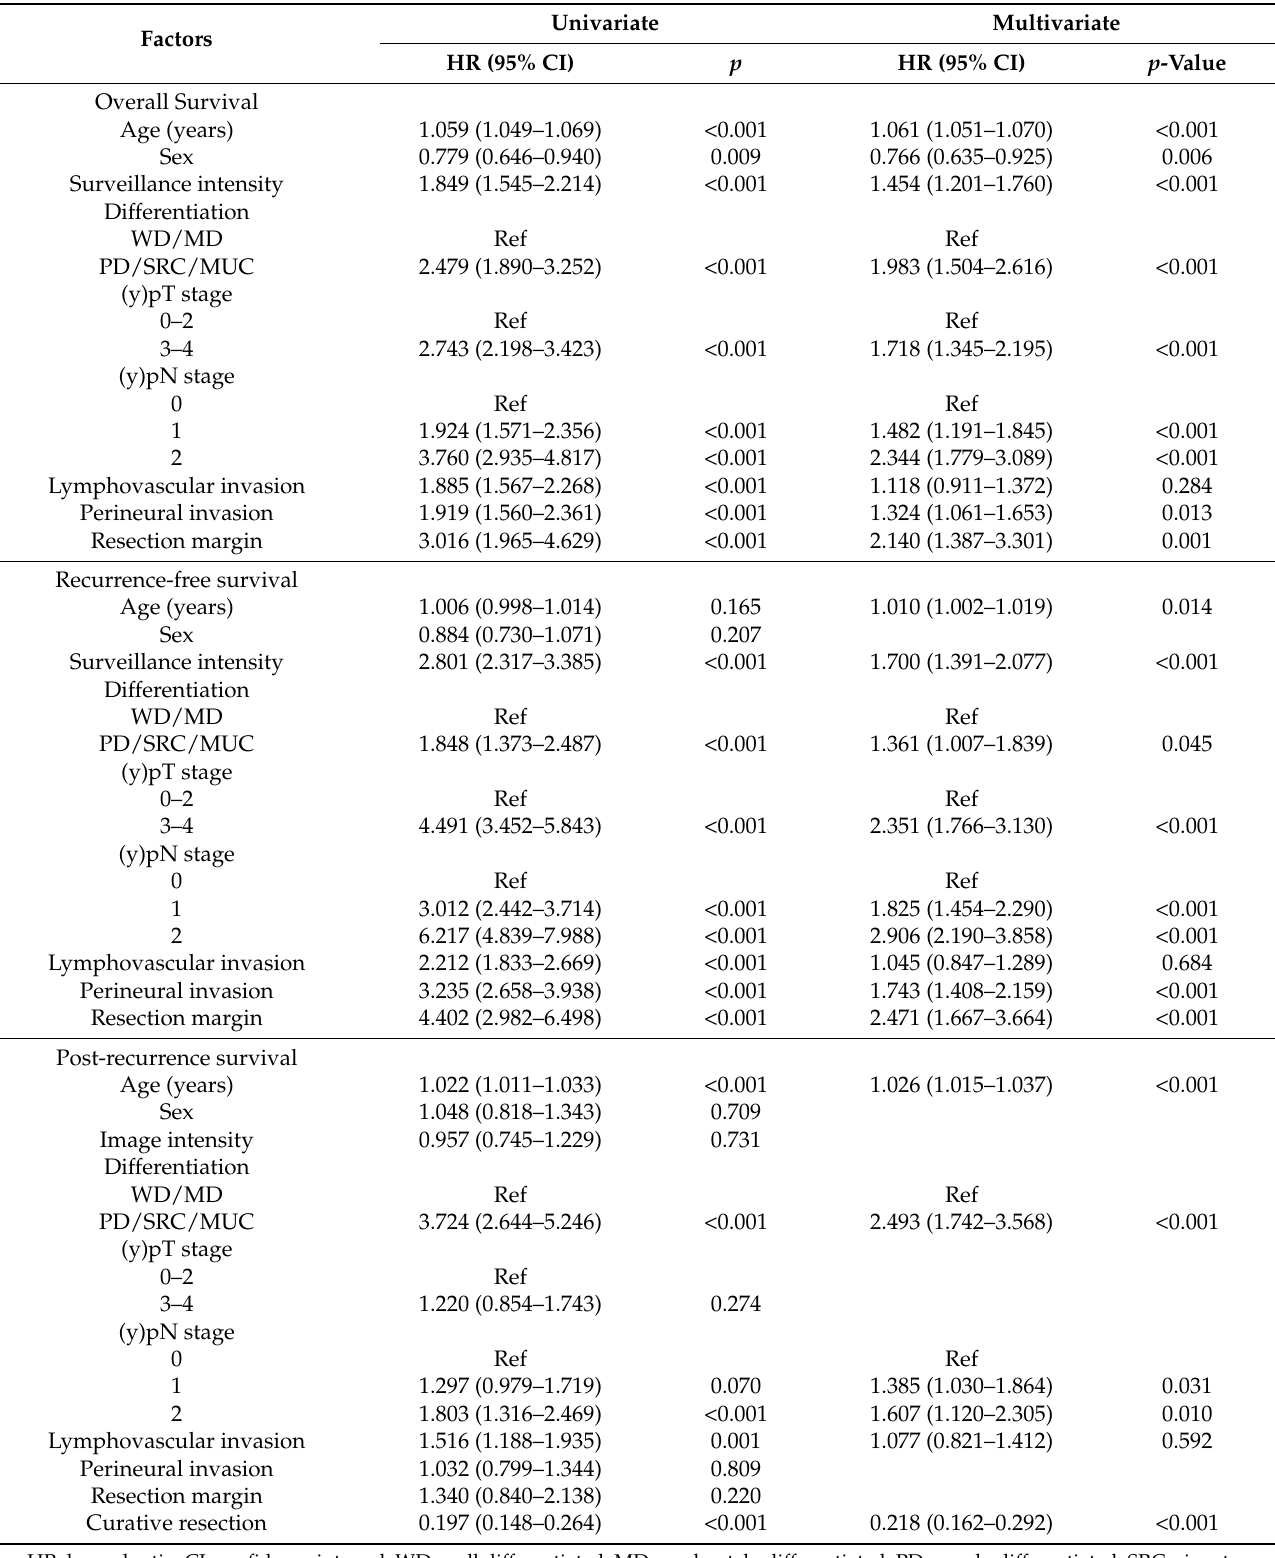
Table 2. Factors affecting survival of